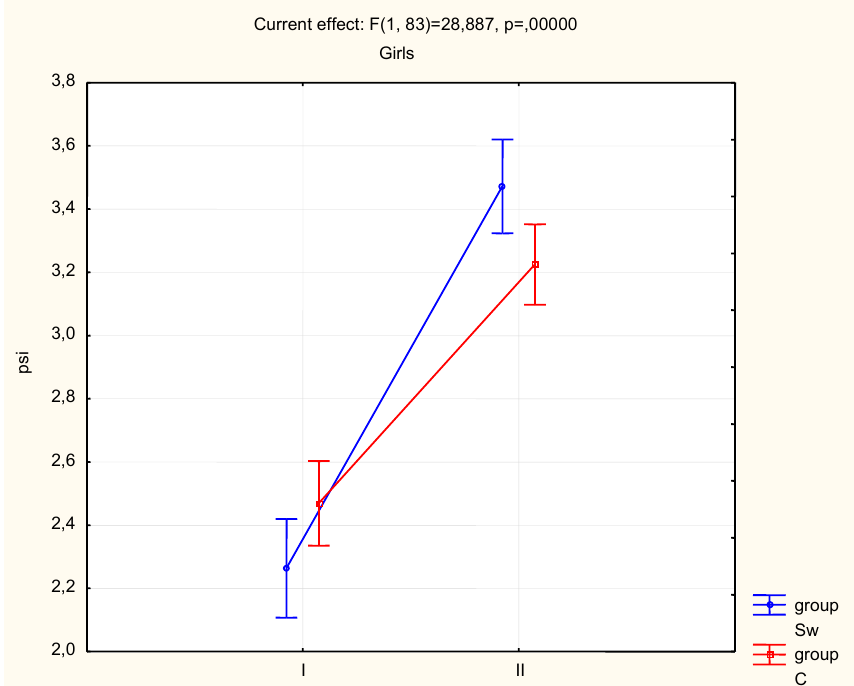
Fig 5. Changes of Handgrip Strength Test (static strength) results in the Swimmers (Sw) and Control (C)